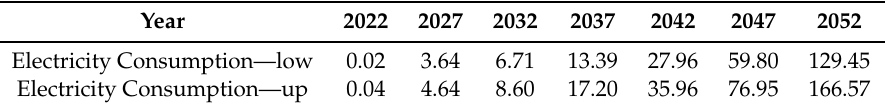
Table 8. Electricity consumption bounds for electric buses in the ISTBUS scenario (PJ).